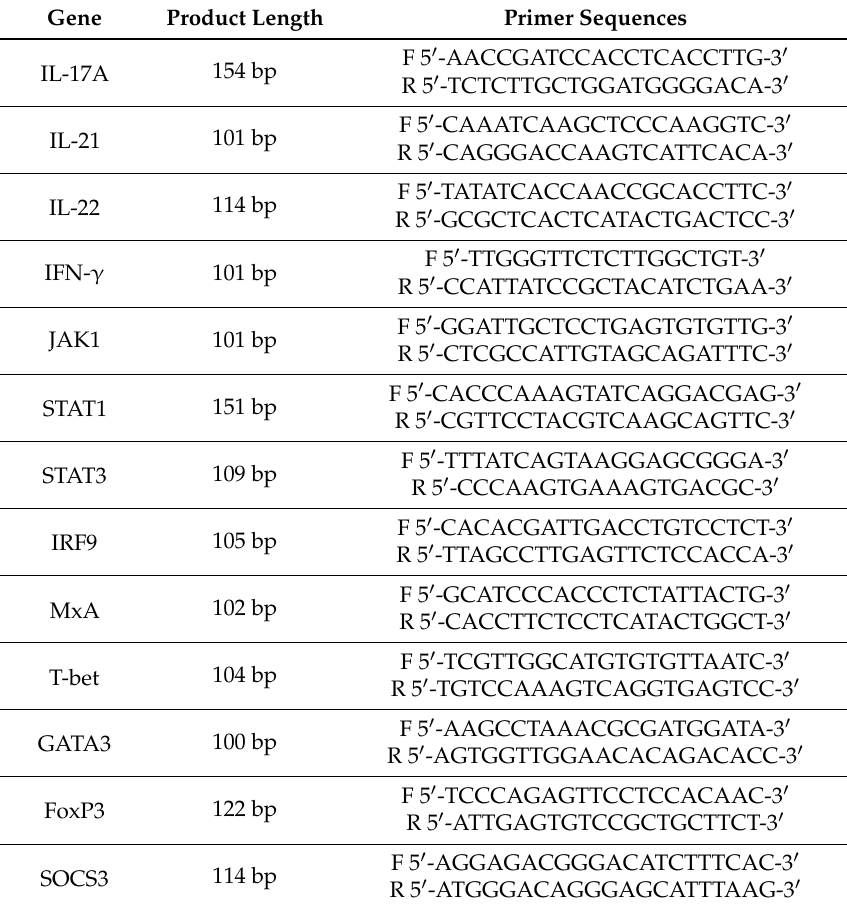
Table 2. Primers used for qRT-PCR